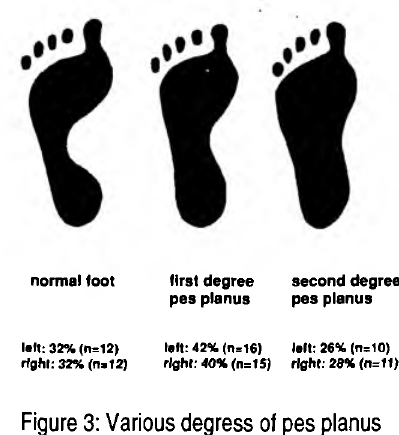
Figure 3: Various degress of pes